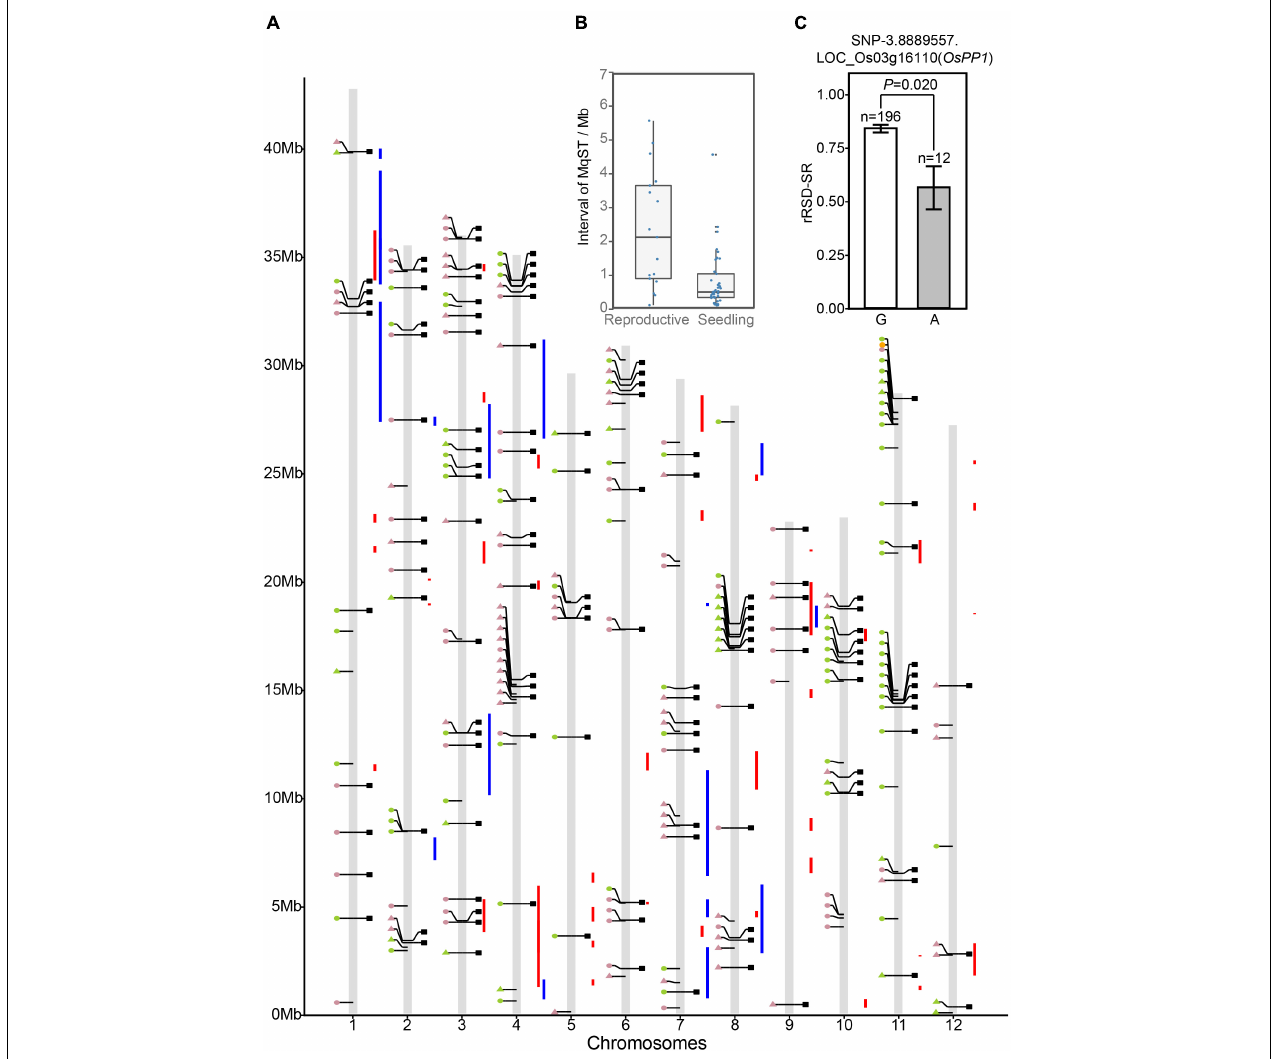
FIGURE 4 | Comparison of the significant association SNPs, Meta-quantitative trait locus (QTL), and differentially expressed genes. (A) Integrated map for association SNPs, Meta-QTL intervals and differentially expressed genes (DEGs). Circles and triangles on the left side of each chromosome represent LFF and not LFF SNPs, respectively. Green and pink colors indicate the association SNPs detected at seedling and reproductive stages, respectively. Squares on the right side of the chromosomes represent the DEGs. Red and blue vertical lines refer to meta-QTL intervals of seedling and reproductive stages, respectively. (B) Distribution of interval length of meta-QTL in reproductive stage (rMqST) and in seedling stage (sMqST). (C) Haplotype analysis of the SNP-3.8889557 associated differentially expressed gene OsPP1 . The n = 196 and n = 12 indicate the number of the accessions harbored “G” and “A” haplotypes, respectively. The average rRSD-SR value of the accessions containing each of the two haplotypes reached statistically significant difference at p <